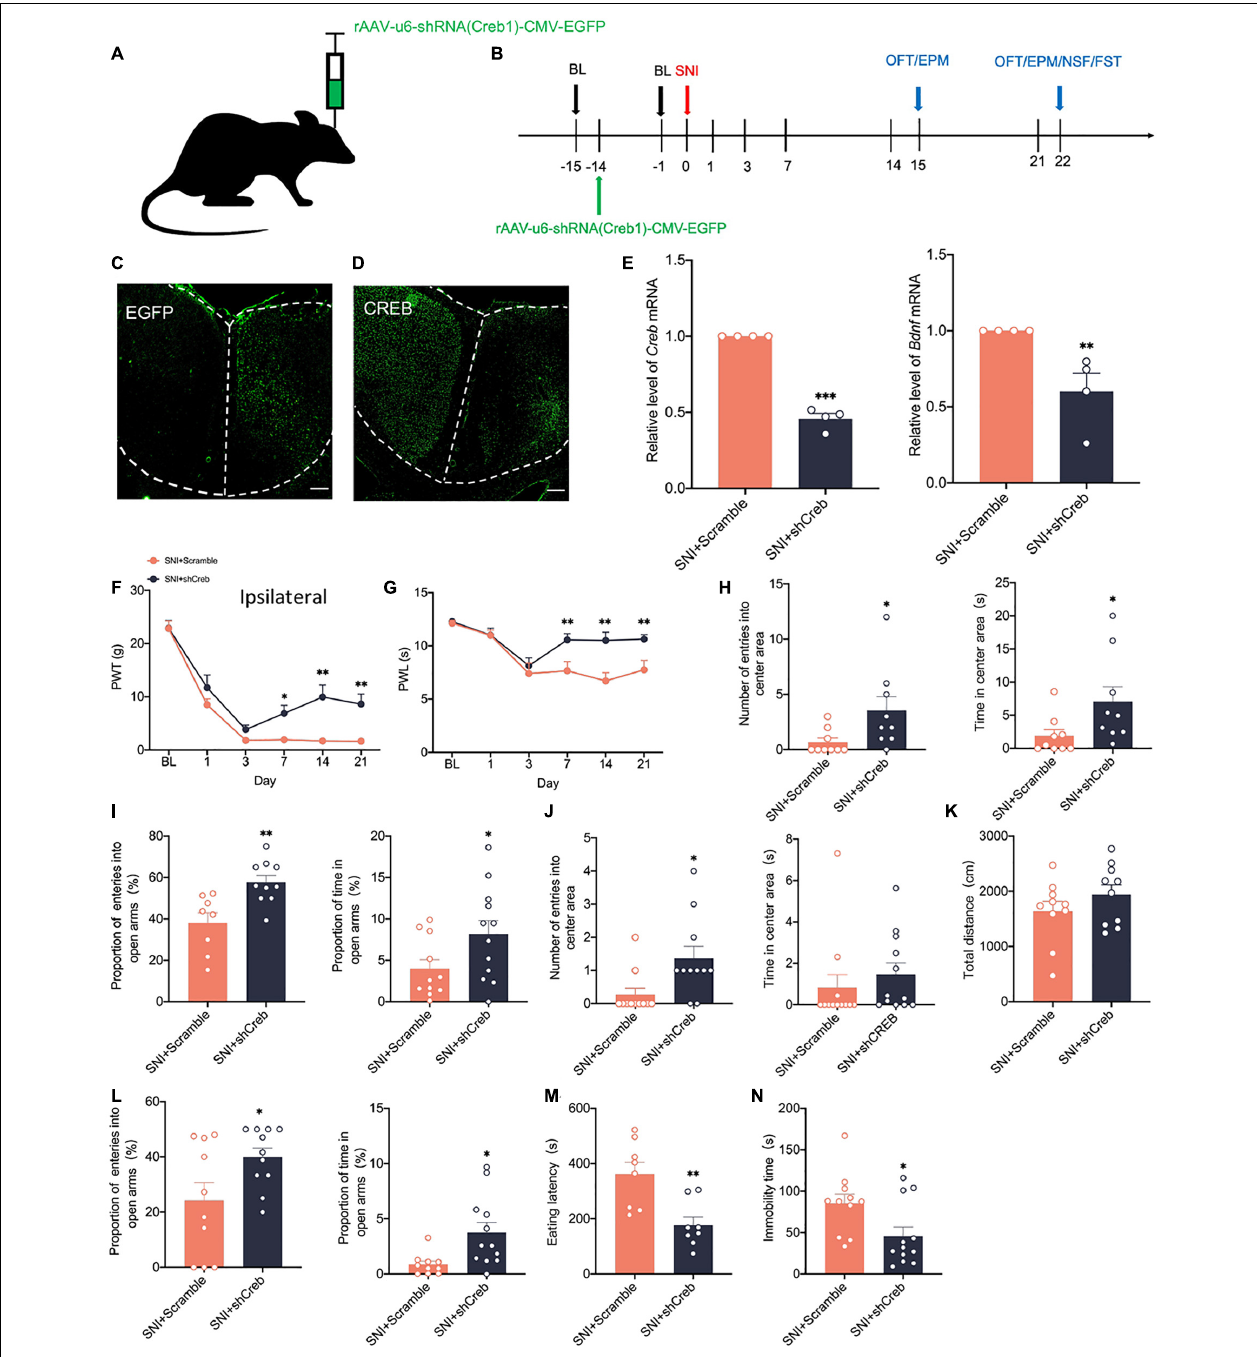
FIGURE 6 | Knockdown of CREB in the ACC alleviates pain hypersensitivity and anxiodepression like behaviors in SNI rats. (A,B) Injection of rAAV-u6-shRNA Creb1-CMV-EGFP into the contralateral ACC of SNI rats (A) and experimental timing (B) . (C) The virus was successfully injected into the ACC and stably transfected (Scar bar = 50 µ m). (D) CREB was significantly knocked down within the ACC (Scar bar = 50 µ m). (E) Knockdown of CREB in the ACC decreased CREB/BDNF mRNA in the ACC ( n = 4 rats/group). (F,G) Knockdown of CREB in the ACC alleviated PWT (F) and PWL (G) in SNI rats ( n = 12 rats/group). (H) Knockdown of CREB in the ACC increased the number of entries into the center area and time in the center area in SNI rats at 14 days after surgery ( n = 12 rats/group). (I) Knockdown of CREB in the ACC increased the proportion of entries into the open arms and the proportion of time in the open arms in SNI rats at 14 days after surgery ( n = 12 rats/group). (J) Knockdown of CREB in the ACC increased the number of entries into the center area, but not the time in the center area in SNI rats at 21 days after surgery ( n = 12 rats/group). (K) Knockdown of CREB in the ACC was no significant difference in the total distance traveled by SNI rats at 21 days after surgery ( n = 12 rats/group). (L) Knockdown of CREB in the ACC increased the proportion of entries into the open arms and the proportion of time in the open arms in SNI rats at 21 days after surgery ( n = 12 rats/group). (M,N) Knockdown of CREB in the ACC decreased the eating latency (M) and the immobility time (N) in SNI rats at 21 days after surgery ( n = 12 rats/group). ∗ P < 0.05, ∗∗ P < 0.001, ∗∗∗ P < 0.0001 for SNI + Scramble vs. SNI +